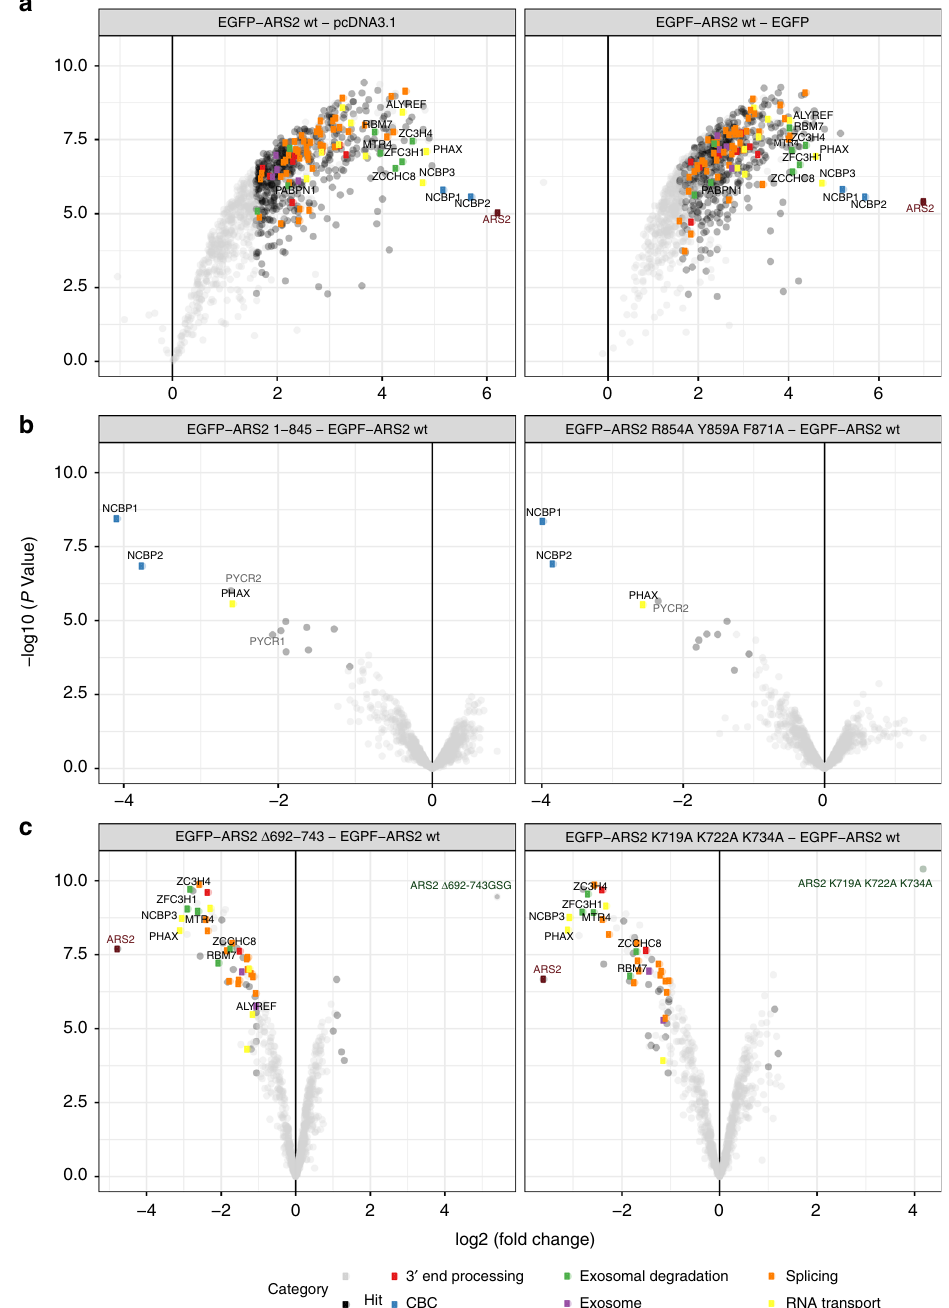
Fig. 5 Identi fi cation of cellular interacting partners of ARS2. HEK 293T/17 cells were transfected with different EGFP-tagged ARS2 constructs or EGFP or pcDNA3.1 as control. After EGFP pull down, the associated proteins were analysed by LC – MS/MS. Volcano plots show the enrichment of EGFP – ARS2 wt associated proteins against the enrichment of the proteins for: a pcDNA3.1 (left) and EGFP (right); and the enrichment of proteins associated with ARS2 mutants against ARS2 wt: b EGFP – ARS2 1 – 845 (left) and EGFP – ARS2 R854A R859A F871A (right). c EGFP – ARS2 Δ 692 – 743GSG (left) and EGFP – ARS2 K719A K722A K734A (right). Three independent af fi nity puri fi cations were performed for each bait, except for the ARS2 wt in b for which only one pull down was performed. Bait proteins (dark red for wild type and dark green for mutant), CBC (blue), exosomal proteins (purple) and proteins involved in 3 ′ end processing (red), nuclear exosomal degradation (green), splicing (orange) and RNA transport (yellow) are highlighted. A full list of identi fi ed proteins is given in Supplementary Data